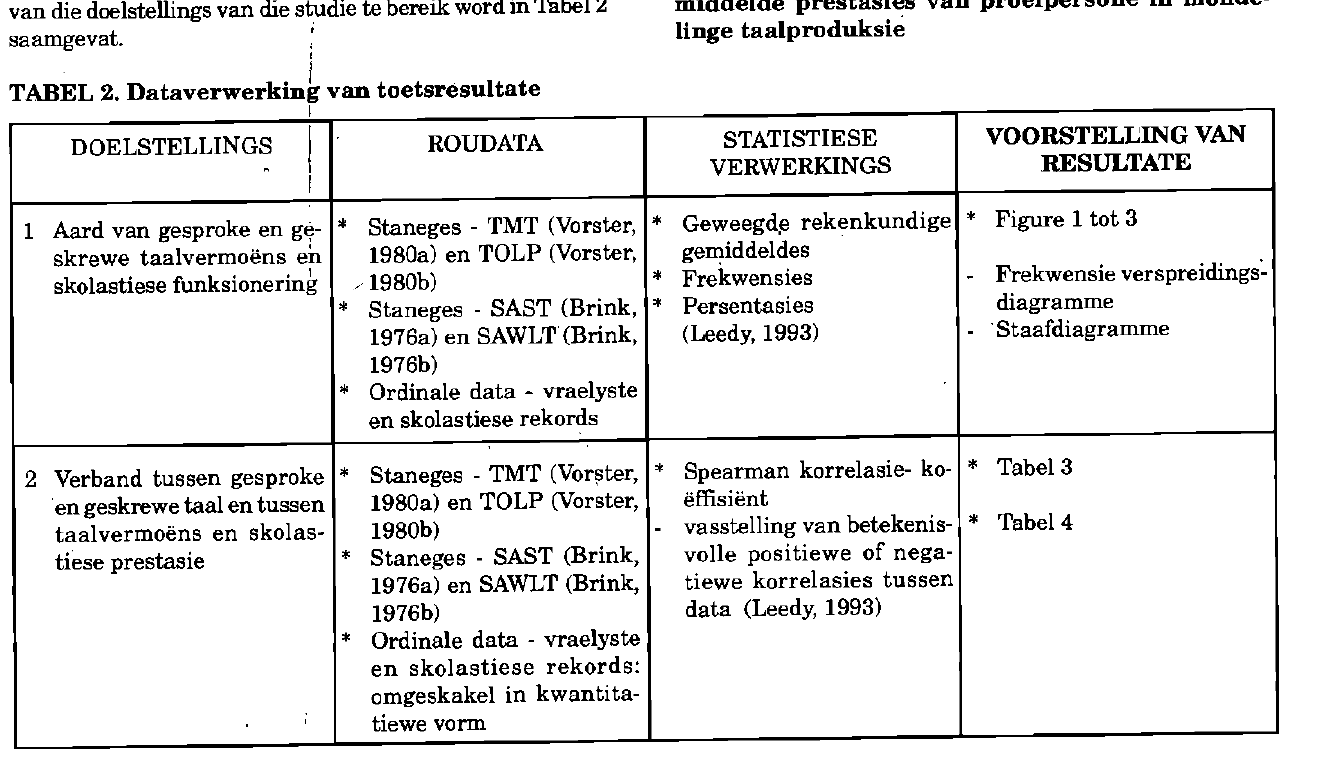
FIGUUR 1: Ondergemiddelde, gemiddelde en boge- middelde prestasies van proefpersone in monde- linge